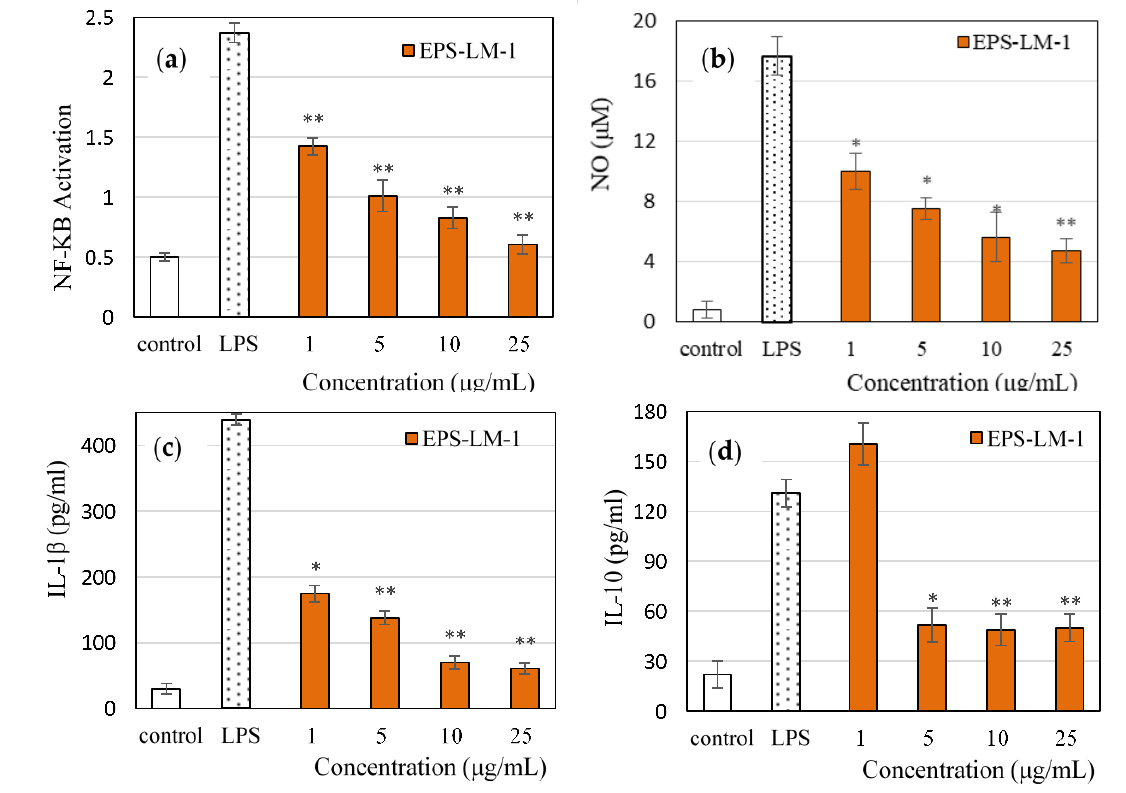
Figure 3. Effects of EPS-LM-1 on four inflammation responses of cells in vitro: ( a ) NO production; ( b ) NF- κ B; ( c ) IL-1 β ; and ( d ) IL-10. Error bars for SD, n > 6. * and ** indicate statistically significant differences from the LPS group at p < 0.05 and p < 0.01 by the Student t-test, respectively. Table 3. Relative potency indexes of EPS-LM-1 compared with EPS [14] on three major inflamma- tory markers (MEC: minimum effective concentration for 50% inhibition).